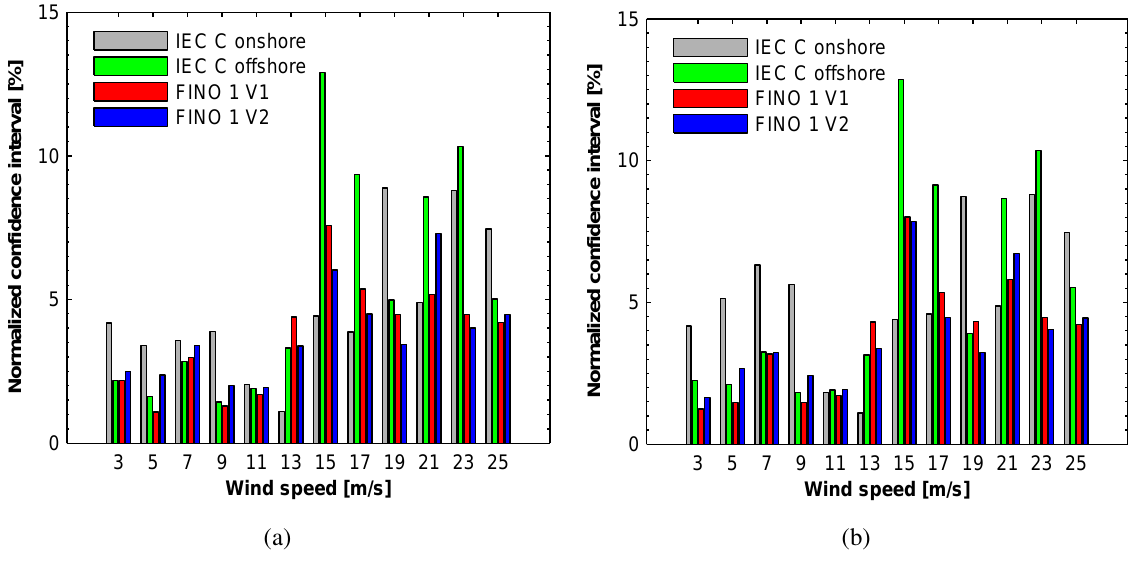
Figure 8. Normalized 90% confidence interval on the p -quantile of the flapwise bending moment based on ( a ) POT; ( b ) ACER